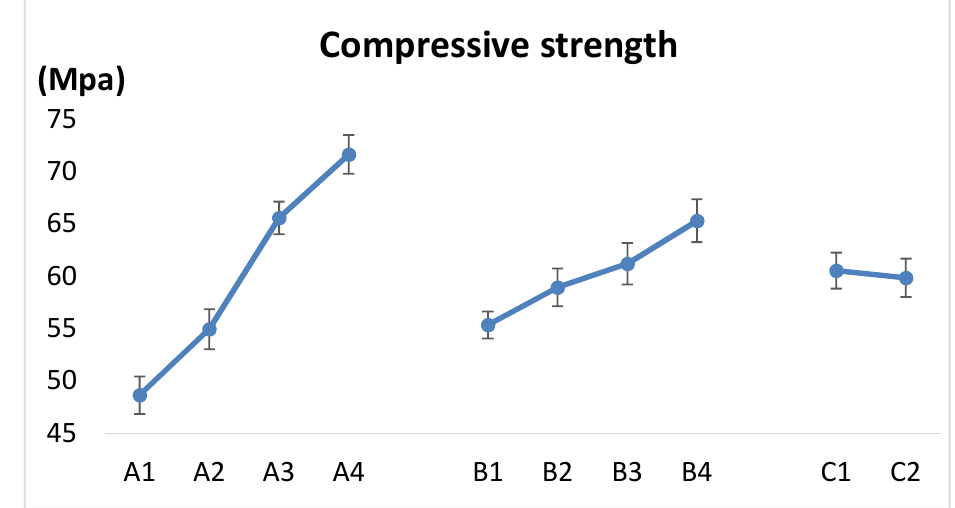
Figure 6. Factors and levels—compressive strength: A—compaction pressure (A1–A4: 75, 100, 124